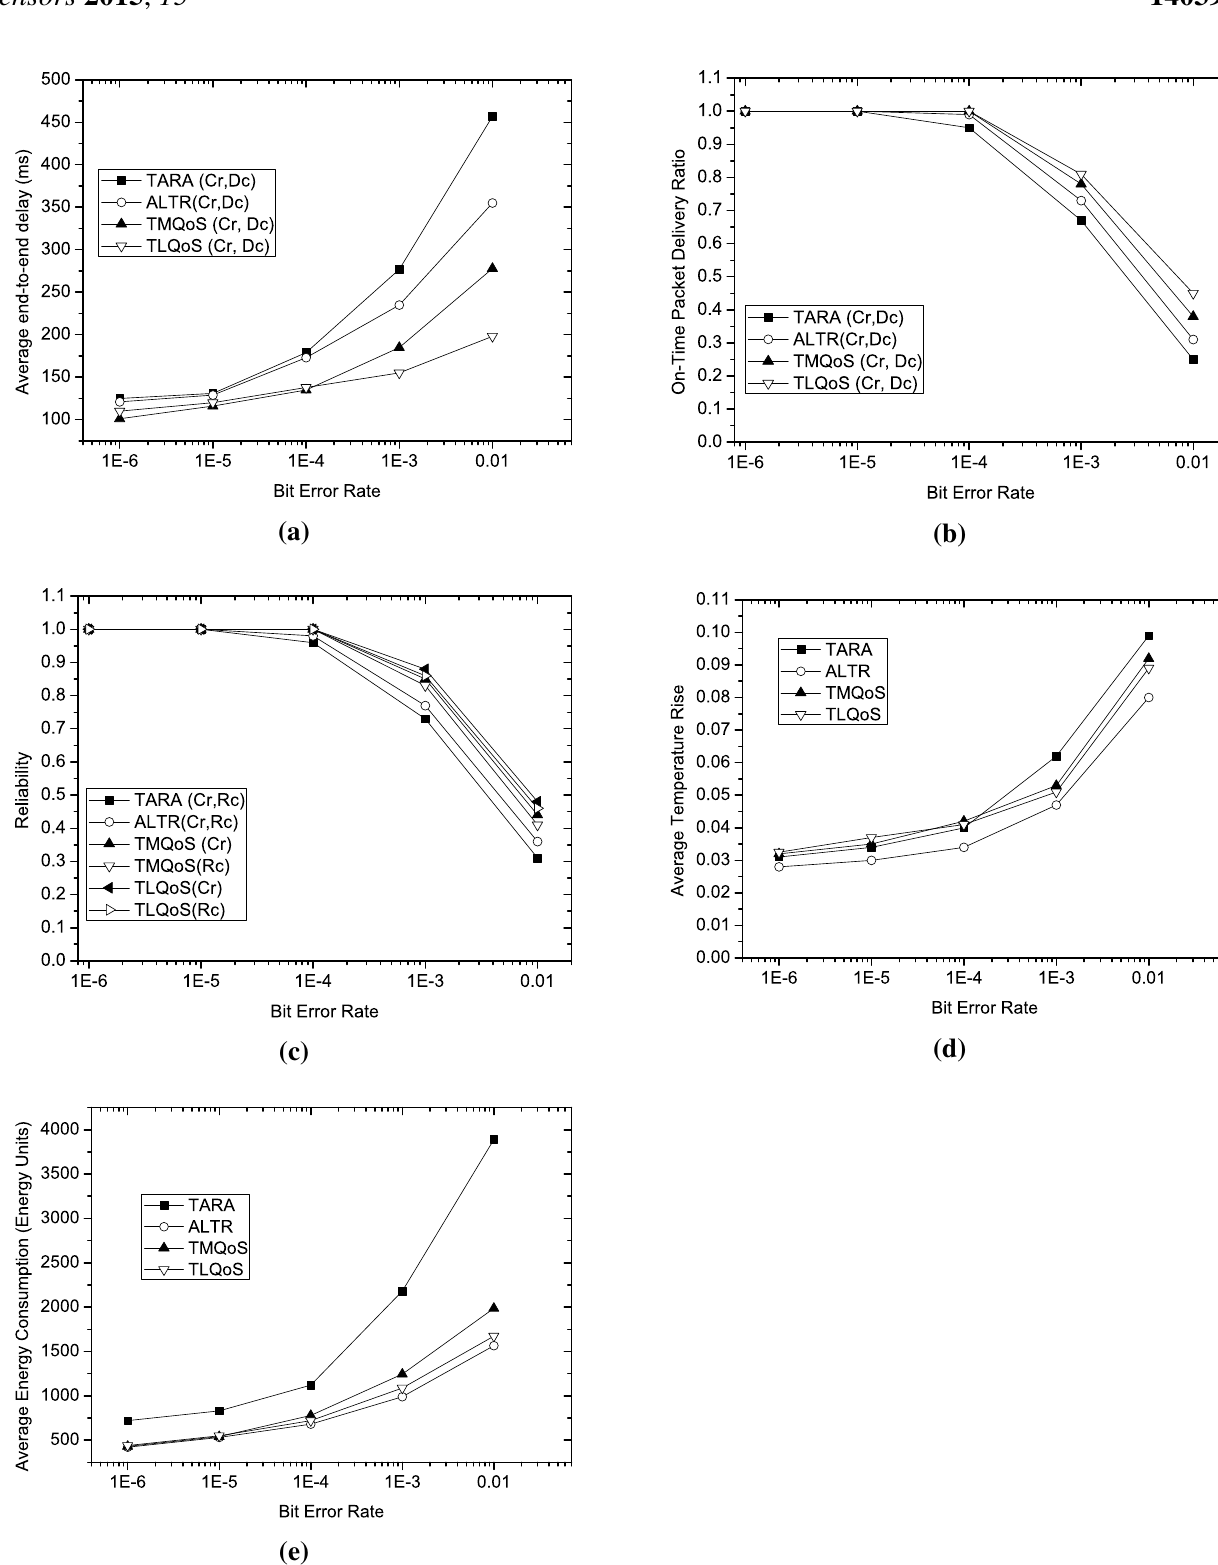
Figure 5. Performance Comparison for different Bit Error Rate. ( a ) Average End-to-End delay varying Bit Error Rate; ( b ) On Time Packet Packet Delivery Ratio varying Bit Error Rate; ( c ) Reliability varying Bit Error Rate; ( d ) Average Temperature Rise varying Bit Error Rate; ( e ) Average Energy Consumption varying Bit Error